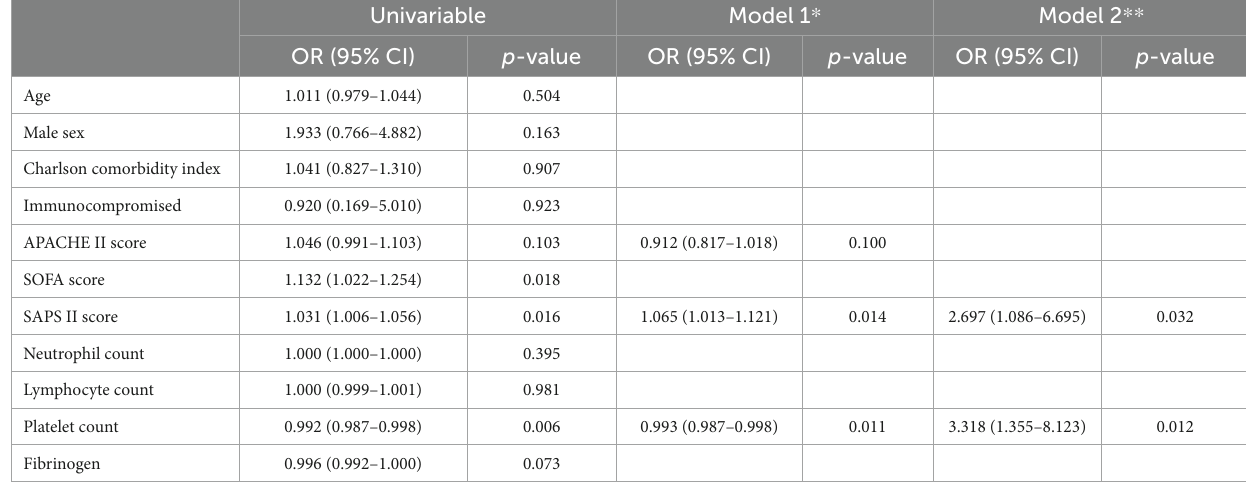
TABLE 4 Risk factors for the development of bacterial superinfection in critically ill patients with COVID-19.